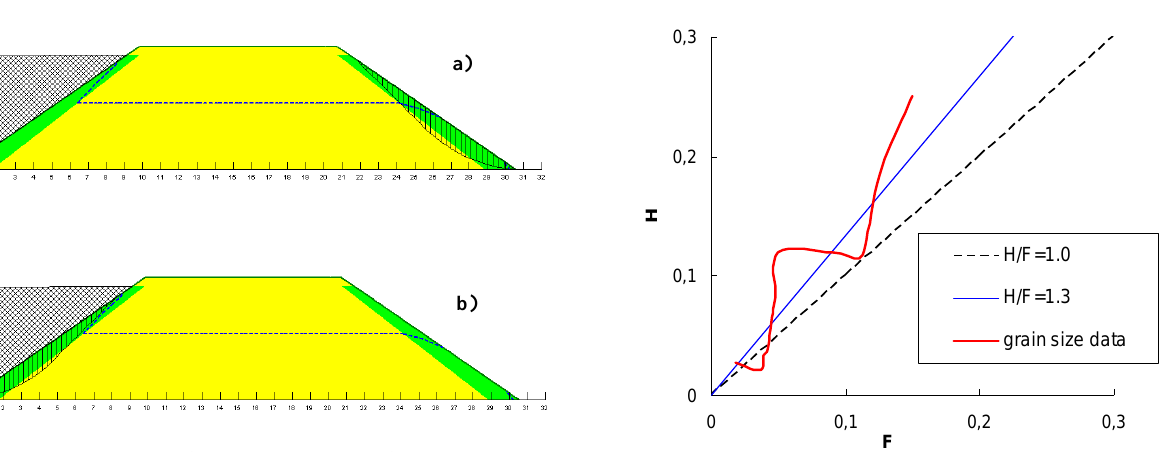
Fig. 16. H/F shape curve calculated for the rockfill grain size curve Figure 16 – H/F shape curves calculated for the grain size distribution curves in Figure 7 and 4 in Fig. 7 and comparison with critical H/F comparison with critical H/F curves. 5